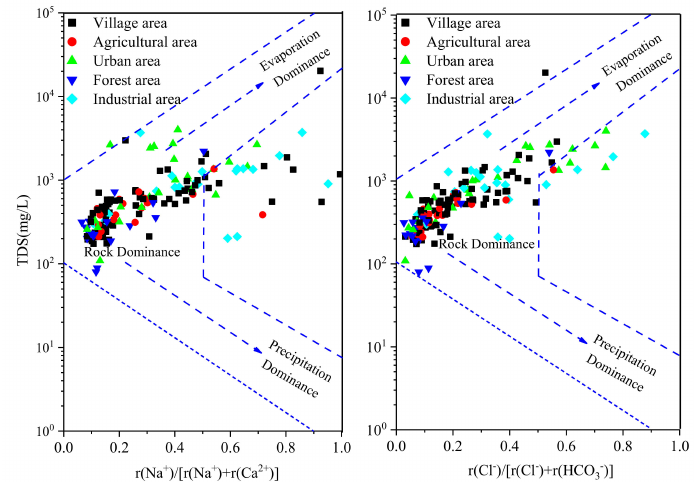
Figure 7. Gibbs diagram for groundwater in Huangshui River